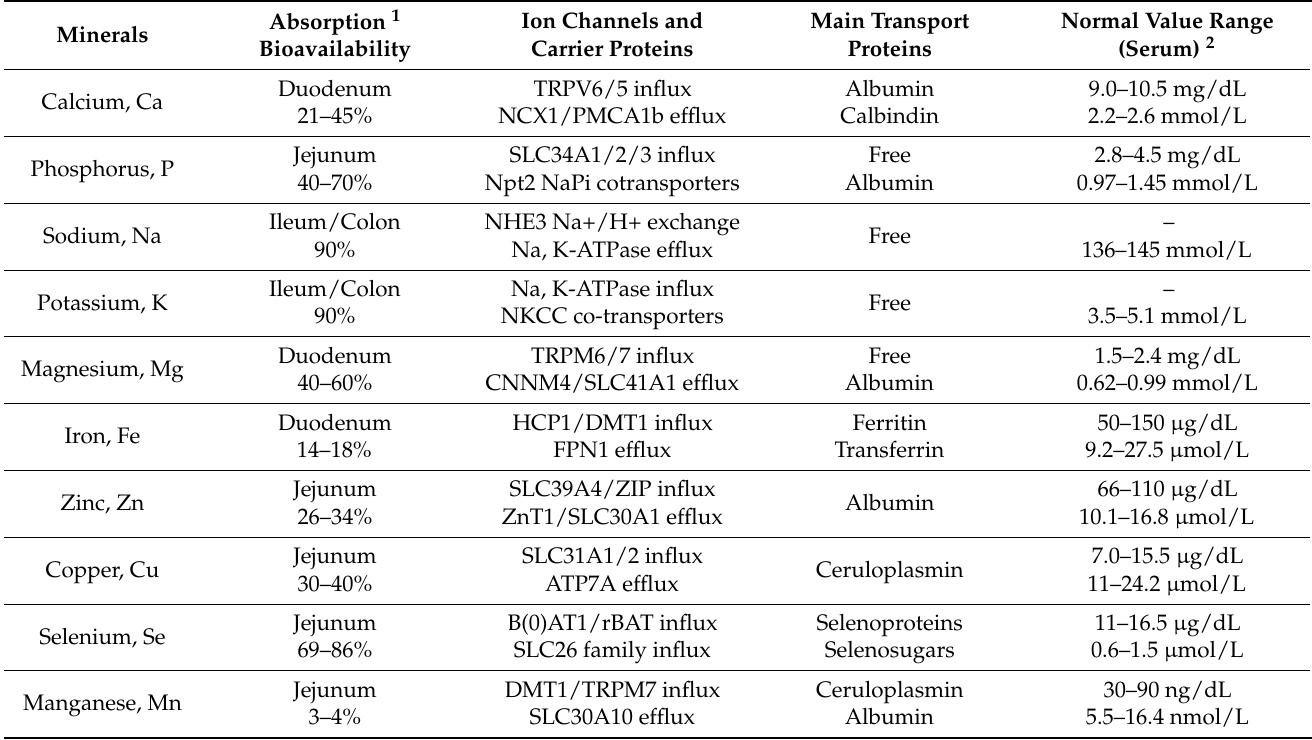
Table 3. Absorption, transport, and normal value ranges of selected